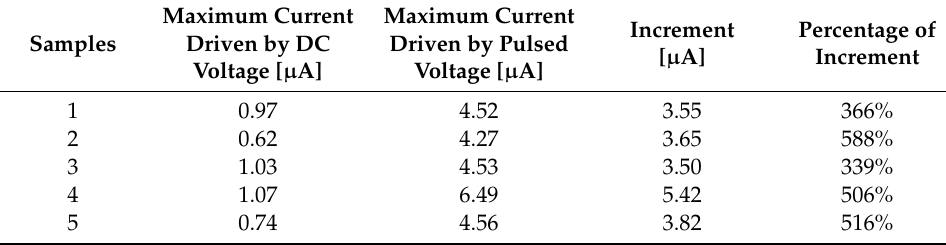
Table 1. Comparison of the electron emission properties of 5 typical